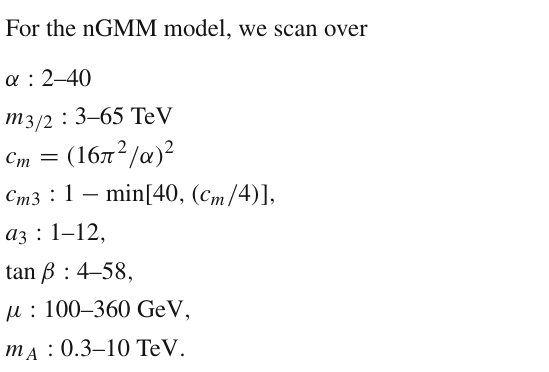
h 2 vs. m (cid:2) Z 1 Z 1 plane from a scan over